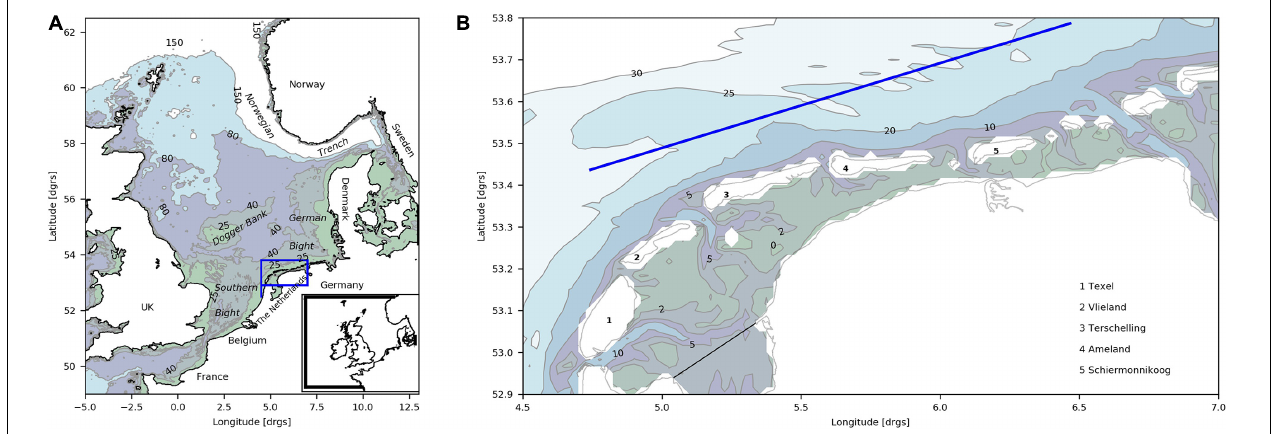
FIGURE 1 | Topography of the area of interest. (A) The North Sea. Inset: full domain of the hydrodynamical model. Blue rectangle: Dutch Wadden Sea (B). (B) Dutch Wadden Sea and approximate route of MSC Zoe (blue line; Table 2 ). Bathymetry contours in m below mean sea level.